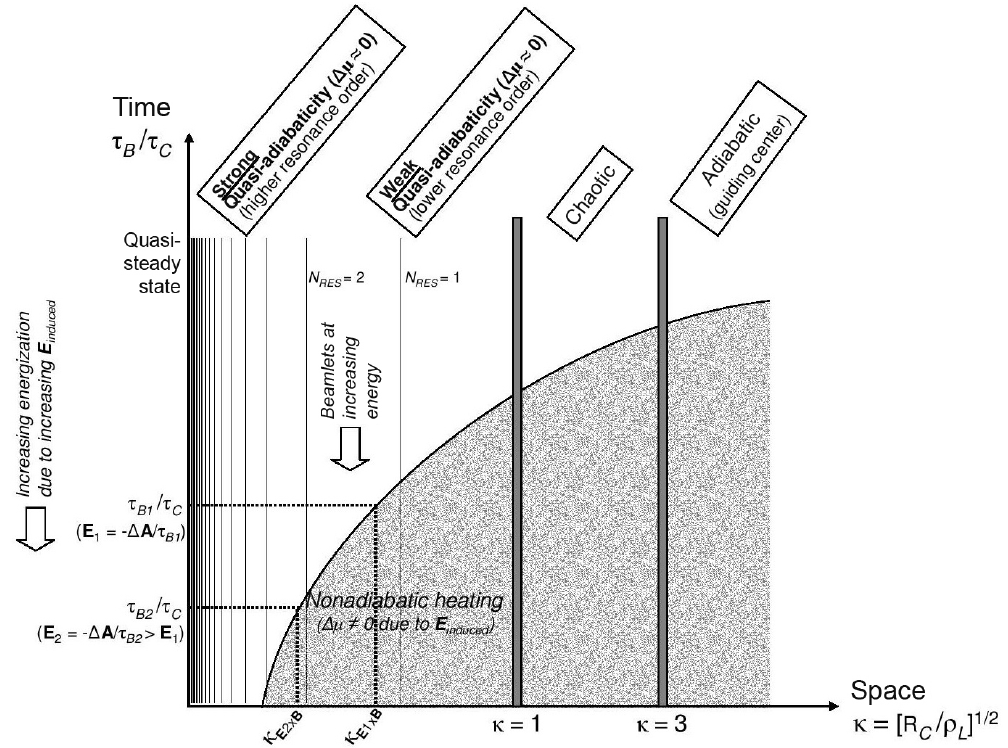
Figure 8. Schematic representation of quasi-adiabaticity evolution depending upon timescale of the magnetic field line